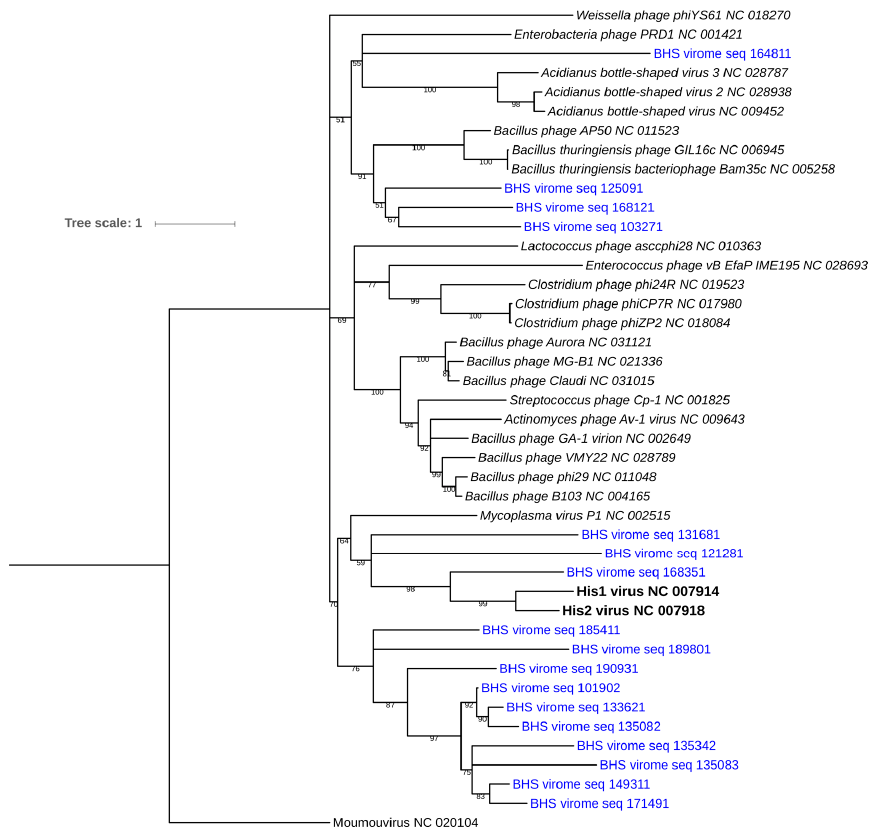
Figure 2. Maximum-likelihood phylogram of the viral polymerase B protein domain. Bootstrap confidence values are expressed in % and are indicated along the branch lengths. Branches with support values lower than 50% were collapsed. Phylogenetic distance is denoted by branch length (to scale) and is indicated in the legend. The Moumou virus (an algal virus) was placed at the bottom of the tree as an outgroup. PolB sequences from the BHS dataset are highlighted in blue and denoted as “BHS virome seq (sequence ID)’. His1 and His2 PolB sequences are shown in bold. All NCBI accession numbers for the reference isolate sequences are indicated after the strain